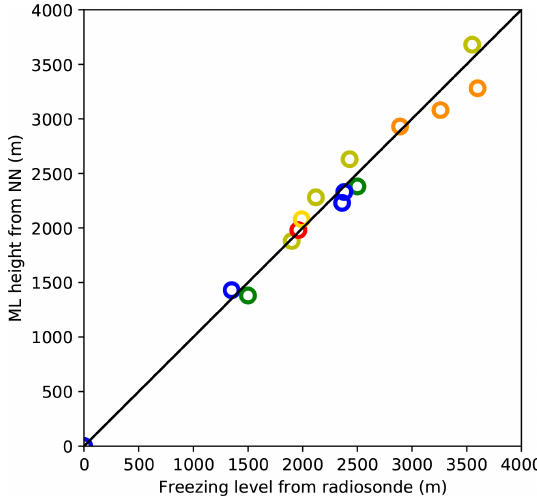
Figure 11. Comparison between the ML height determined by the NN and the freezing level from the radiosonde for Hohenpeißen- berg. The colors denote the time difference between the two heights: no difference (blue), 0–1h (green), 1–2h (olive green), 2–3h (yel- low), 3–4h (orange), and 4–5h (red).